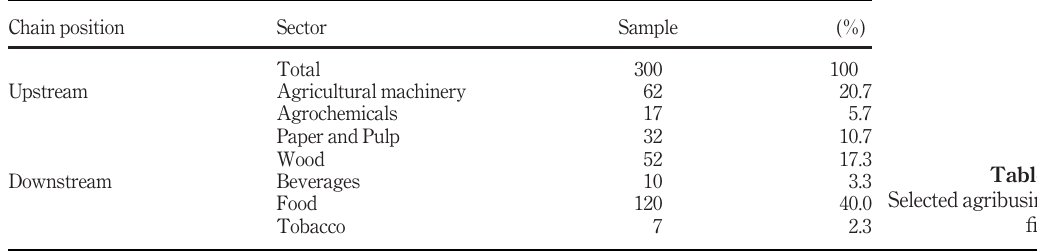
Table 1. Selected